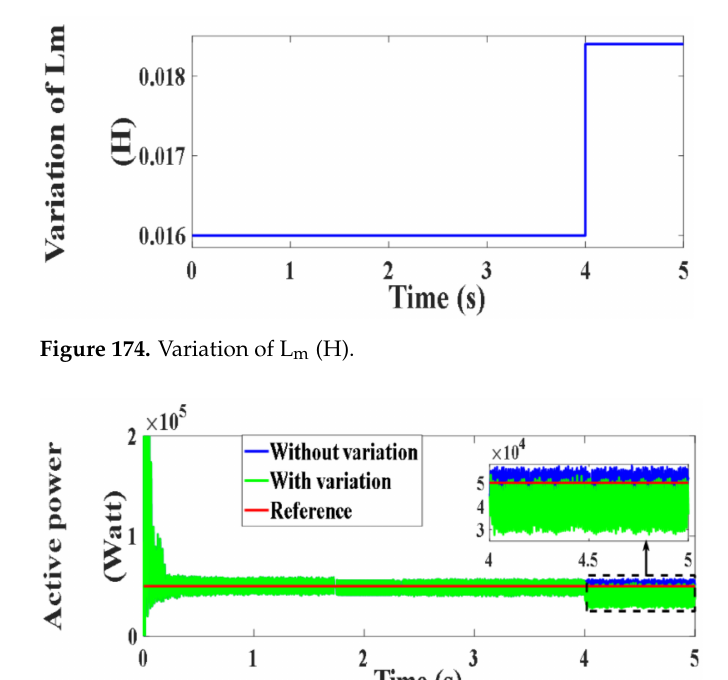
Figure 173. Prime mover operating speeds (rad/s).